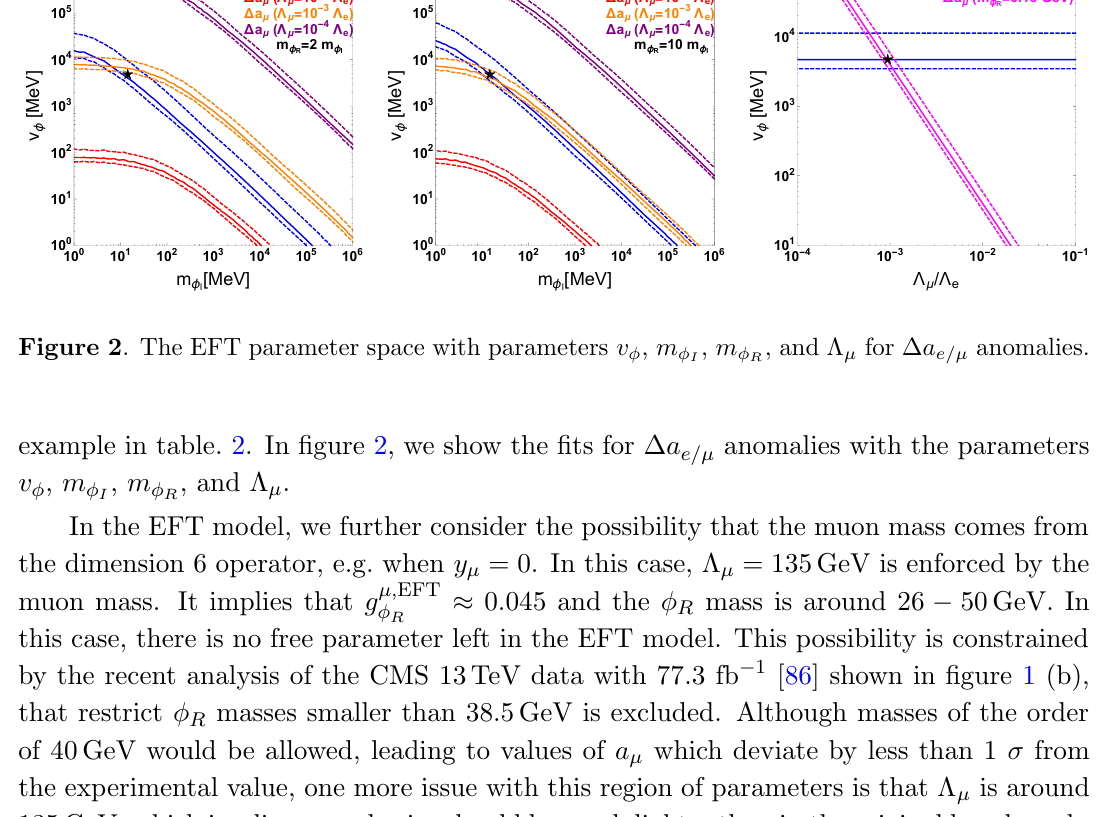
Figure 2 . The EFT parameter space with parameters v (cid:30) , m (cid:30)